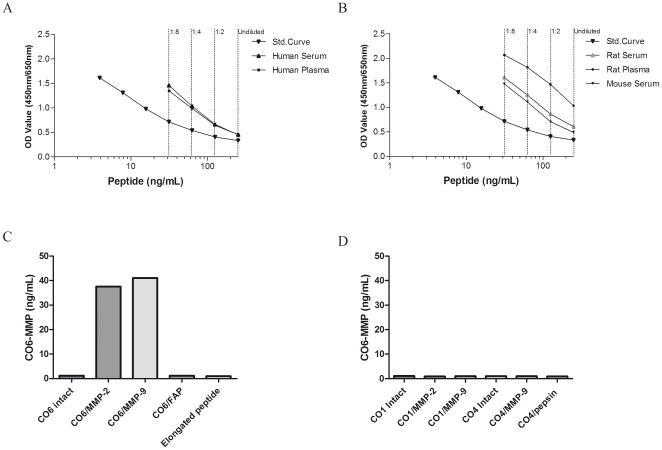
Assay characteristics.(A+B) ELISA run showing typical standard curves and native reactivity against (A) Human serum, plasma, (B) Rodent: Rat serum and plasma; mouse serum, plasma and urine. Native material was run undiluted, 1∶2, 1∶4, and 1∶8 as indicated (—).The signal is seen as the optical density at 450 nm, subtracting the background at 650 nm, as a function of peptide concentration; (C+D) Characterization of the CO6-MMP assay with regards to reactivity against (C) intact type VI collagen (CO6 intact), type VI collagen cleaved by MMP-2 (CO6/MMP-2), type VI collagen cleaved by MMP-9 (CO6/MMP-9), type VI collagen cleaved by fibroblast activation protein (FAP) (CO6/FAP), elongated peptide with extension of one amino acid at the neo-epitope site; (D) Intact type I collagen (CO1), type I collagen cleaved by MMP-2 (CO1/MMP-2), type I collagen cleaved by MMP-9 (CO1/MMP-9), intact type IV collagen (CO4), type IV collagen cleaved by MMP-2 (CO4/MMP-2), type IV collagen cleaved by MMP-9 (CO4/MMP-9), type IV collagen cleaved by pepsin (CO4/pepsin).